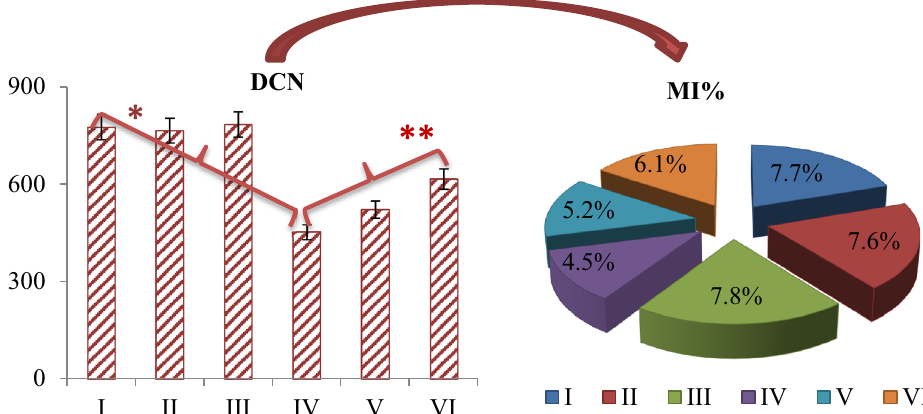
Figure 2. Bmex and glyphosate effects on dividing cell number (DCN) and %MI in A. cepa root tip cells. Group I: control, Group II: 350 mg/L Bmex, Group III: 700 mg/L Bmex, Group IV: 500 mg/L glyphosate, Group V: 500 mg/L glyphosate + 350 mg/L Bmex, Group VI: 500 mg/L glyphosate + 700 mg/L Bmex. *indicates the statistical difference between Groups I and IV, **indicates a statistical difference between Groups IV and VI ( p < 0.05). 10,000 cells in each group were analyzed for MI.